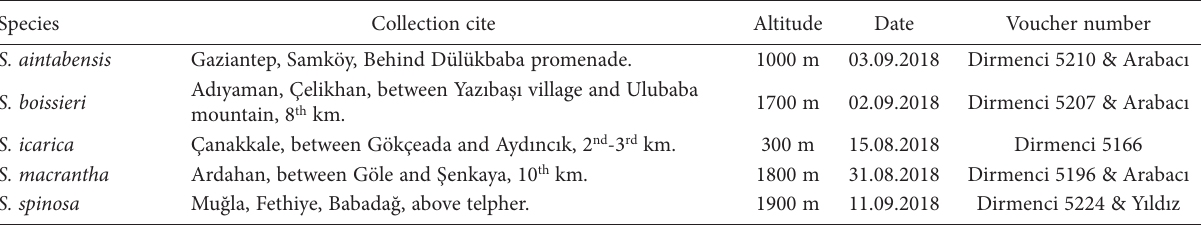
Table 1. The collection information and localities of studied Satureja species.